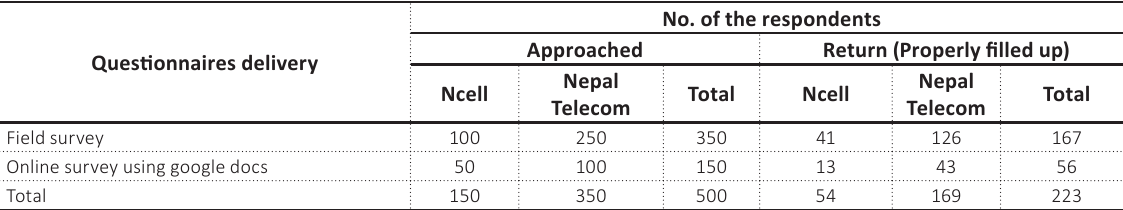
Table 2. The mode of delivery and questionnaire return Questionnaires delivery